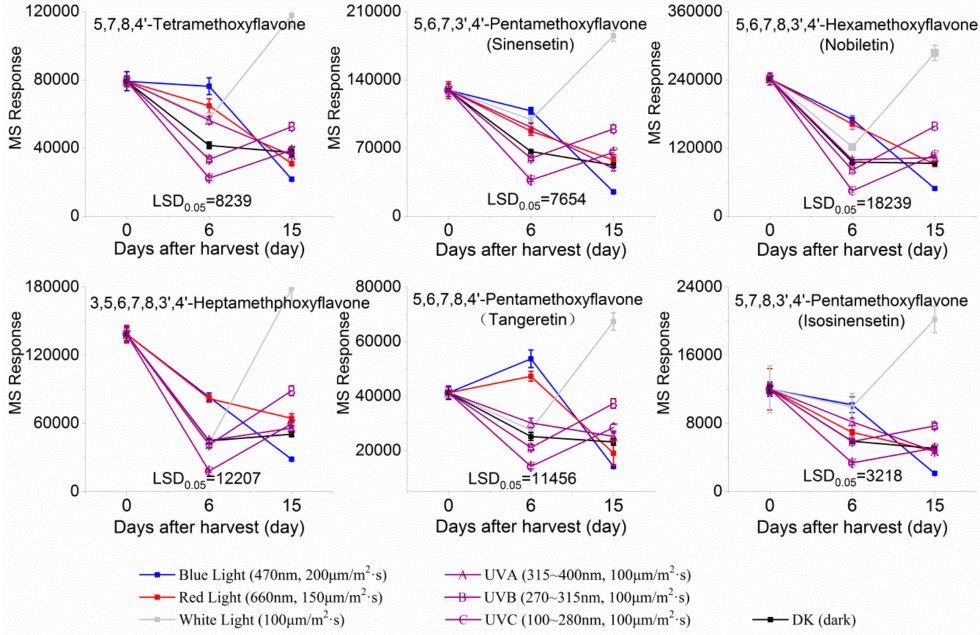
Figure 2. MS response of PMFs in the segments of Newhall navel orange during light irradiation and the removal